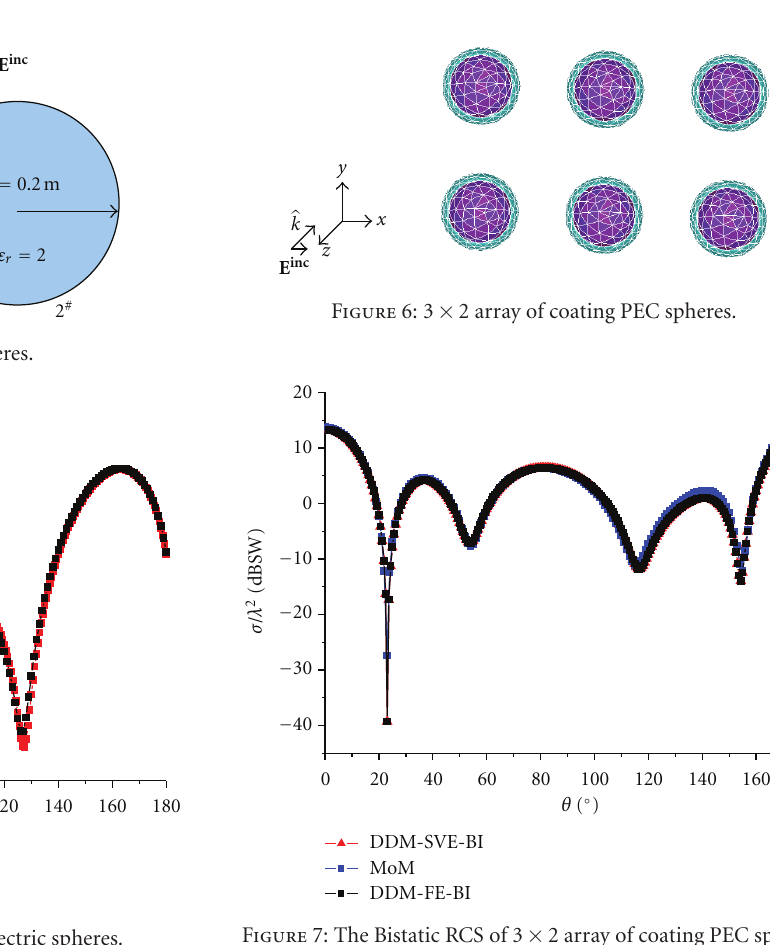
Figure 5: The Bistatic RCS of two dielectric spheres.